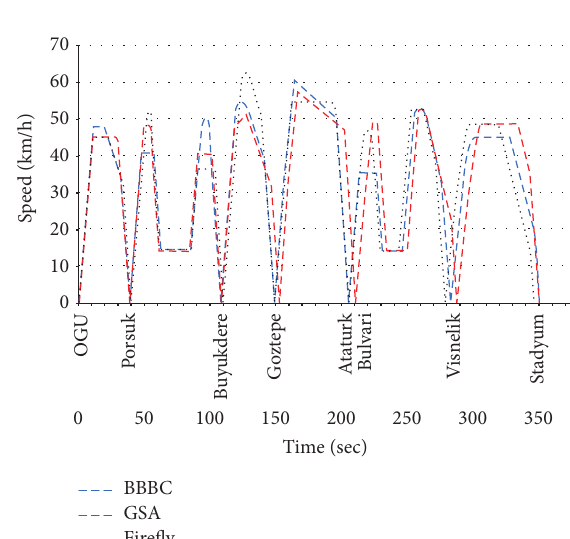
Figure 8: Speed-time graph for all algorithms (with